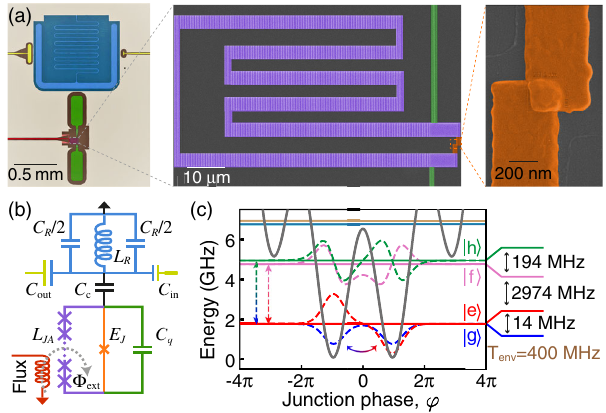
FIG. 1. Device, circuit, and energy-level diagram. (a) Left: False-colored optical microscope image of the fluxonium coupled to a readout resonator (blue) along with flux (red) and input- output (yellow) lines. Middle: Scanning electron micrograph of the large junction array (purple) and the small Josephson junction (orange). Right: Enlarged view of the small junction. (b) Circuit diagram for the heavy-fluxonium qubit. (c) Energy-level diagram of the heavy fluxonium at the flux-frustration point ( Φ Φ 2 ). The gray line represents the potential well. The first six 0 = energy eigenstates are depicted by the colored lines; dashed lines show the wave functions for the first four levels with correspond- ing color. The fluxonlike transition j g i ↔ j e i is marked with a solid arrow, while plasmonlike transitions j g i ↔ j h i and j e i ↔ j f i are marked with dashed